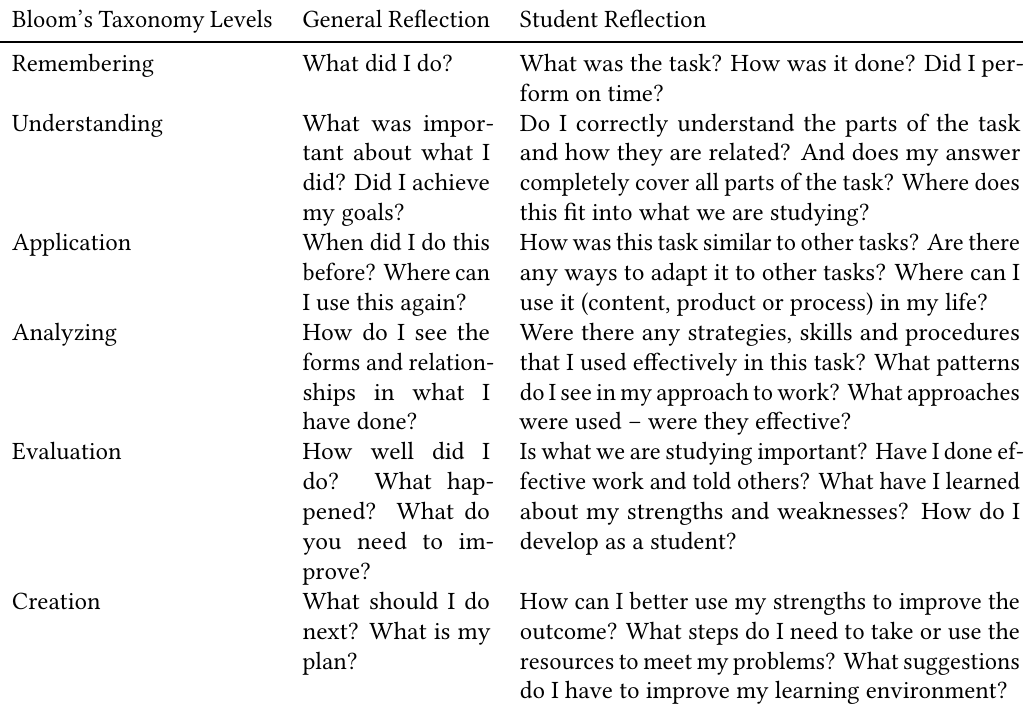
Bloom taxonomy levels based on reflection